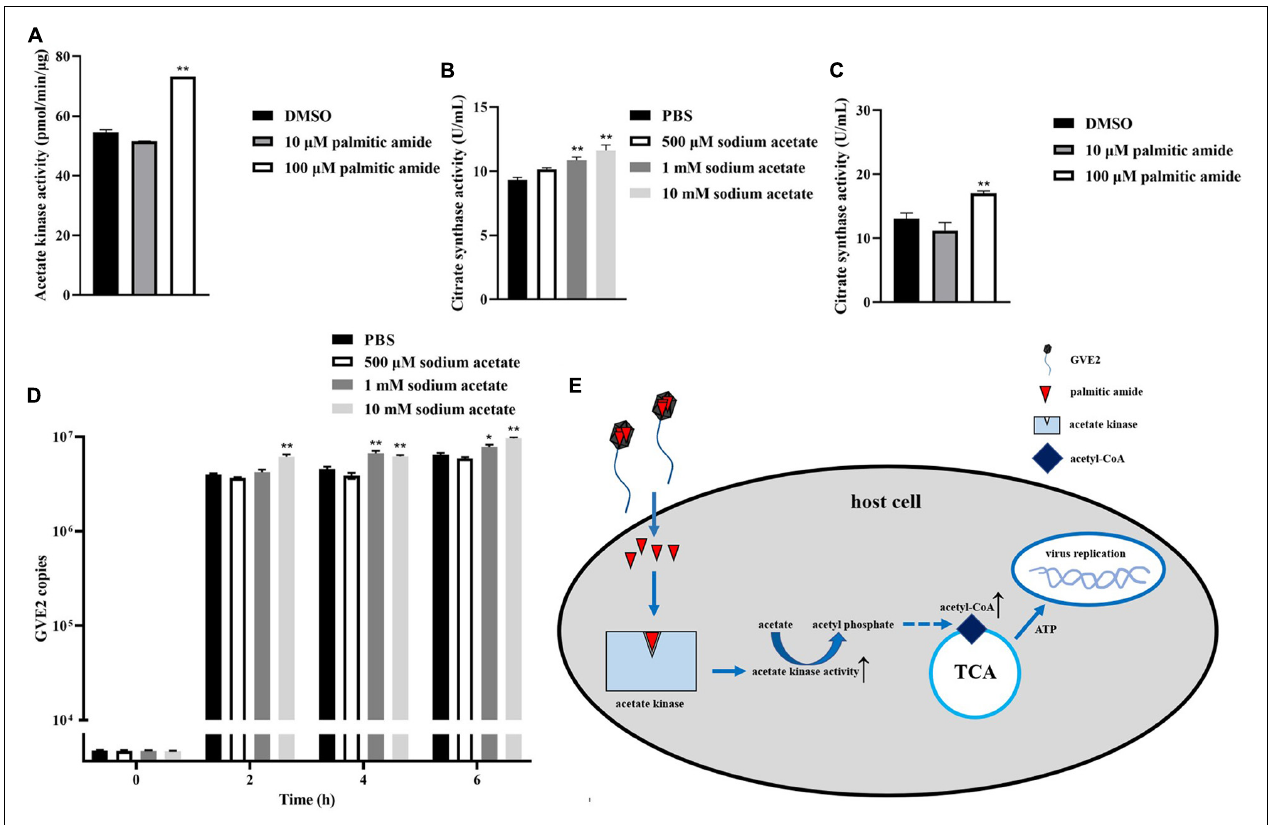
FIGURE 5 | Influence of palmitic amide-mediated energy metabolism on virus infection. (A) Influence of palmitic amide on the activity of acetate kinase. The acetate kinase was incubated with palmitic amide at different concentrations. Then the enzymatic activity was examined. DMSO was included in the assays as a control. (B) Role of sodium acetate in tricarboxylic acid cycle (TCA cycle). Geobacillus sp. E263 was added with different concentrations of sodium acetate. Twenty four hours later, the bacterial citrate synthase activity was determined. PBS was used as a control. (C) Impact of palmitic amide on the citrate synthase activity. Geobacillus sp. E263 was added with 10 or 100 µ M of palmitic amide and then cultured at 60 ◦ C for 24 h. DMSO was used a control. The bacterial citrate synthase activity was examined. (D) Effects of the palmitic amide-mediated TCA cycle on virus infection. The GVE2-infected Geobacillus sp. E263 was added with sodium acetate at different concentrations (500 µ M, 1 mM, and 10 mM). At different time after treatment, the GVE2 copies were determined using quantitative real-time PCR. PBS was used as a control. (E) Model for the palmitic amide-mediated energy metabolism in virus infection. In all panels, the statistical significance of difference between treatments was indicated with asterisks (* p < 0.05, ** p <